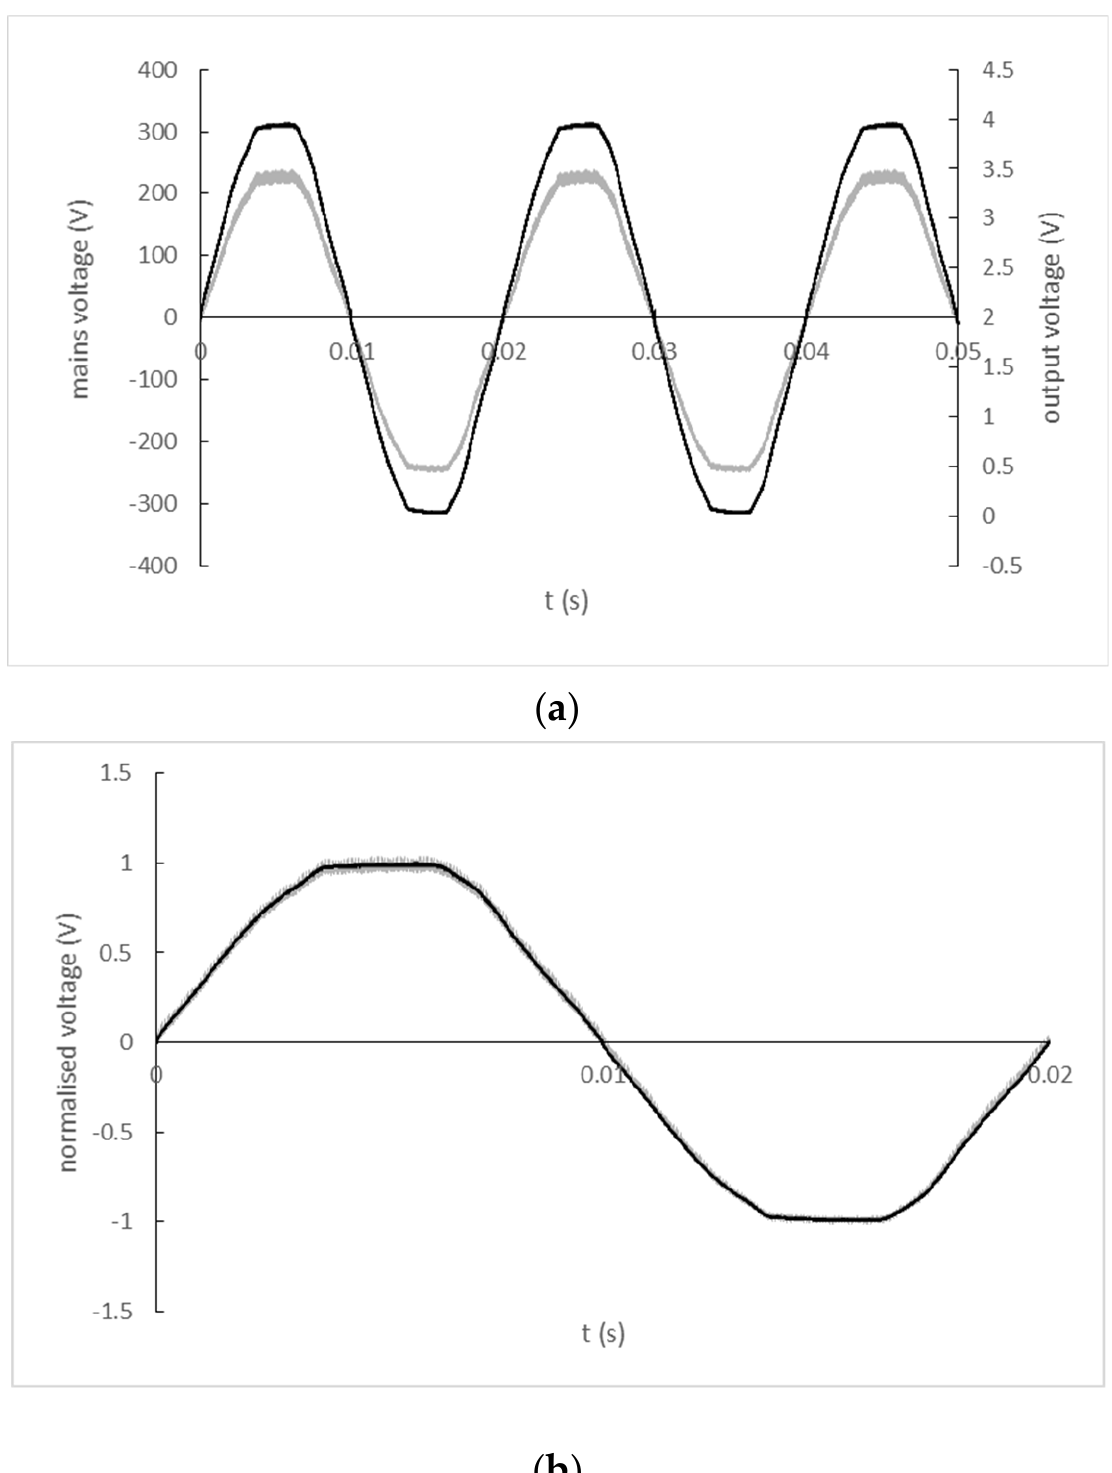
Figure 15. ( a ) The input and output signal record of AMC1211 isolated amplifier (black line—mains; grey line—output); ( b ) Normalized input and output waveforms of AMC1211 isolated amplifier (black line—mains; grey line—output).